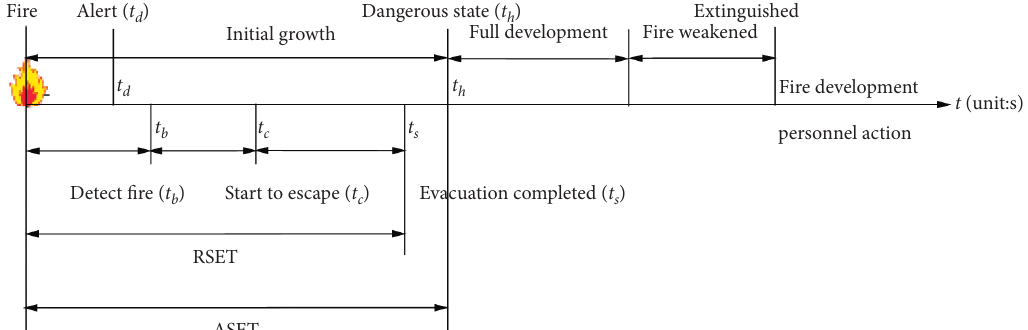
Figure 1: Personnel safety evacuation rule